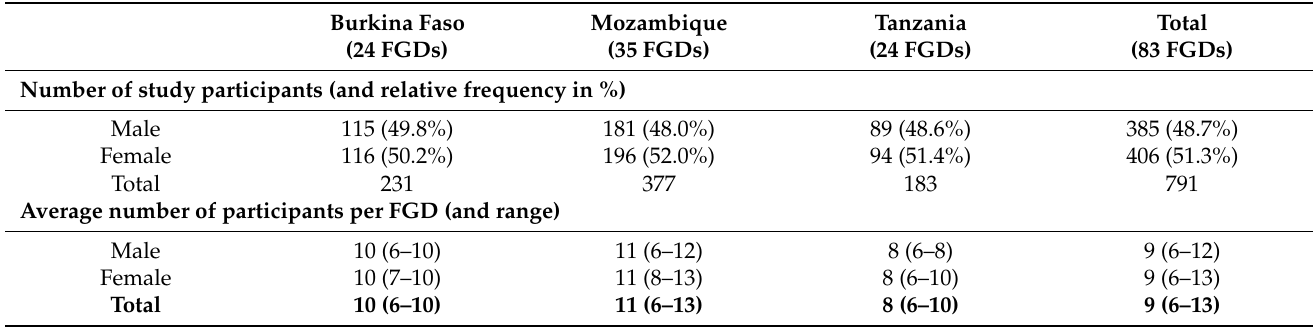
Table 1. Characteristics of study participants. Number of study participants and sociodemographic characteristics by country and in total (FGD: focus group